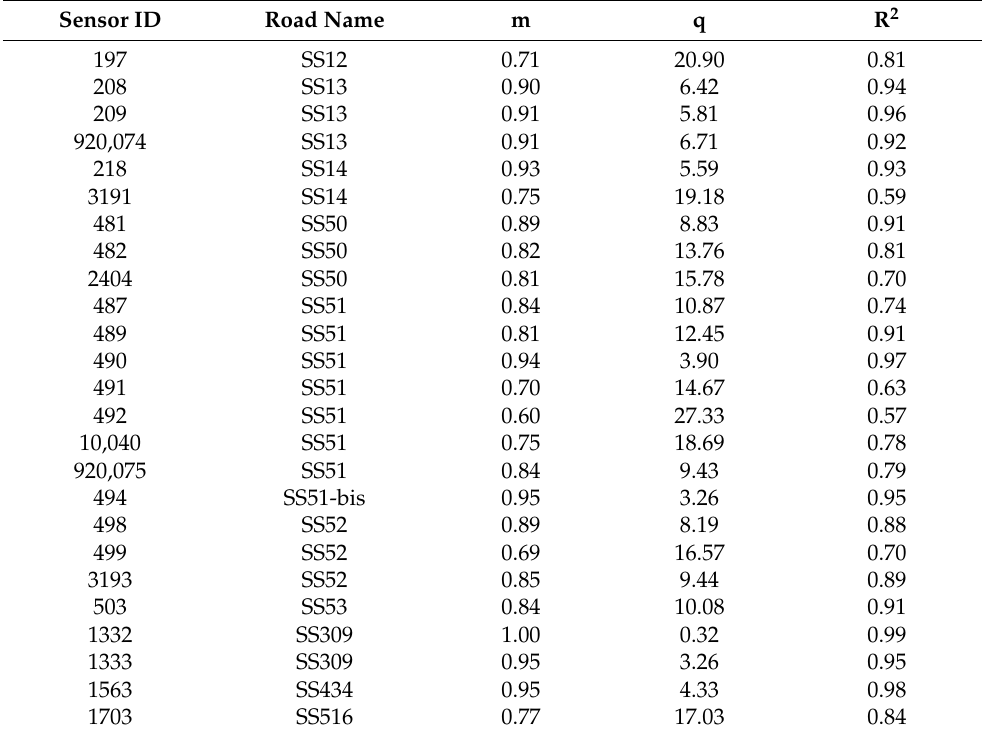
Table A4. Comparison between HCD and sensors speeds through angular coefficients m, and intercepts q of the regression lines, and coefficient of determination R 2 in Dir